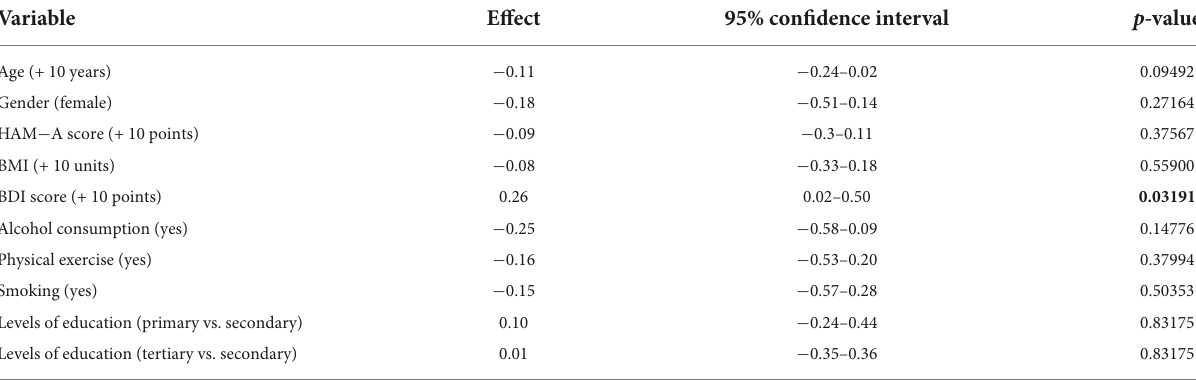
TABLE 3 Results of multivariable modeling of HbA1c (Hungarian patients with type 2 diabetes, 2018–2020, n = 338). Variable Effect 95% confidence